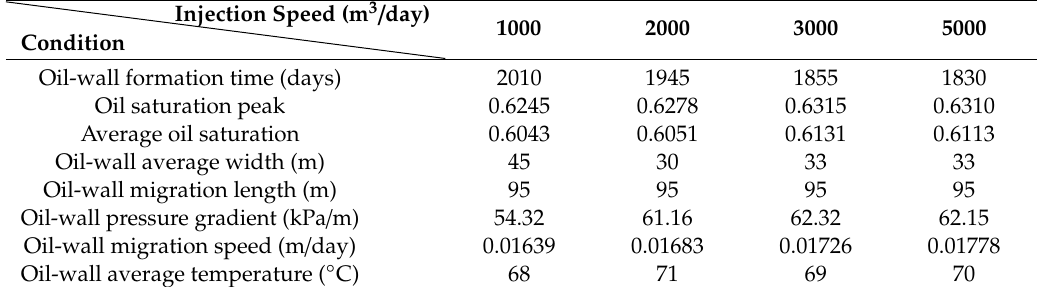
Table 6. Characteristic parameters of oil-wall with di ff erent air injection speed.